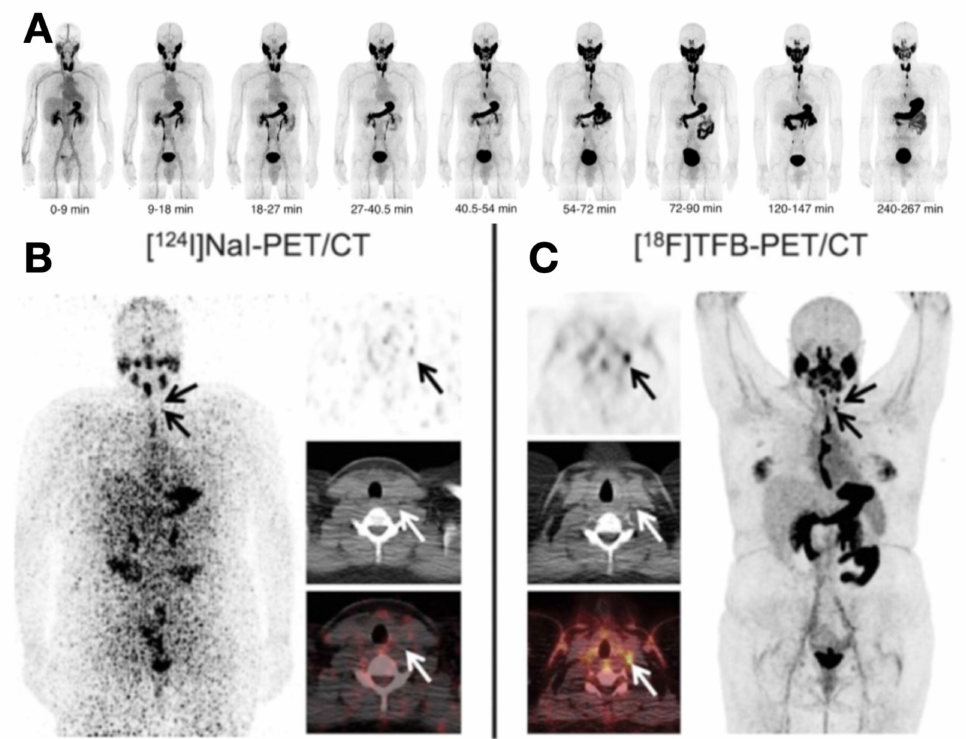
Figure 3. Evaluation of thyroid cancer via [ 18 F]TFB-PET/CT and [ 124 I]NaI-PET/CT. ( A ) Biodistribution of [ 18 F]TFB at various time points on PET images. [ 18 F]TFB accumulated rapidly in the thyroid and other normal tissues like the salivary gland and stomach within 10–30 min. Reproduced with permission from [50], copyright 2017 Society of Nuclear Medicine and Molecular Imaging. ( B , C ) A comparison between [ 124 I]NaI-PET/CT and [ 18 F]TFB-PET/CT in a 26-year-old patient post-thyroidectomy. ( B ) [ 124 I]NaI-PET/CT was unremarkable for PTC. ( C ) In contrast, [ 18 F]TFB-PET/CT revealed two foci in the left lateral cervical region. Reproduced with permission from [51], copyright 2018 Wolters Kluwer